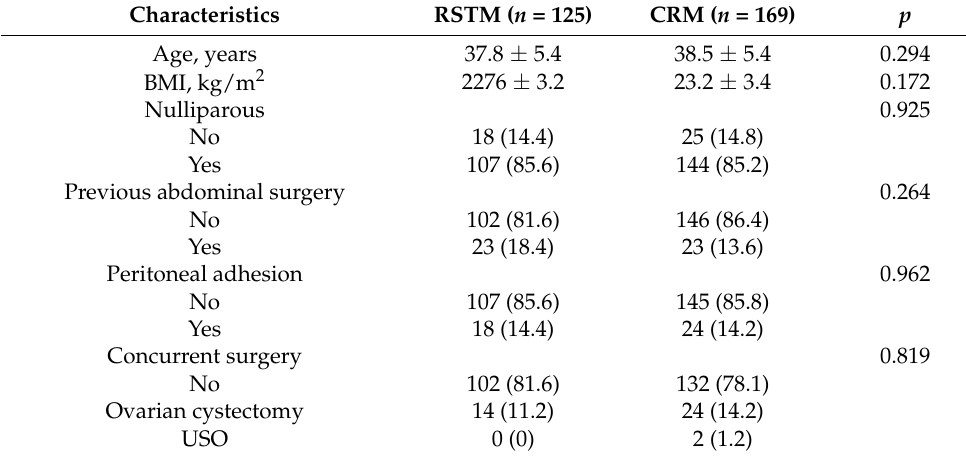
Table 2. Baseline characteristics of myomectomy patients after propensity score matching